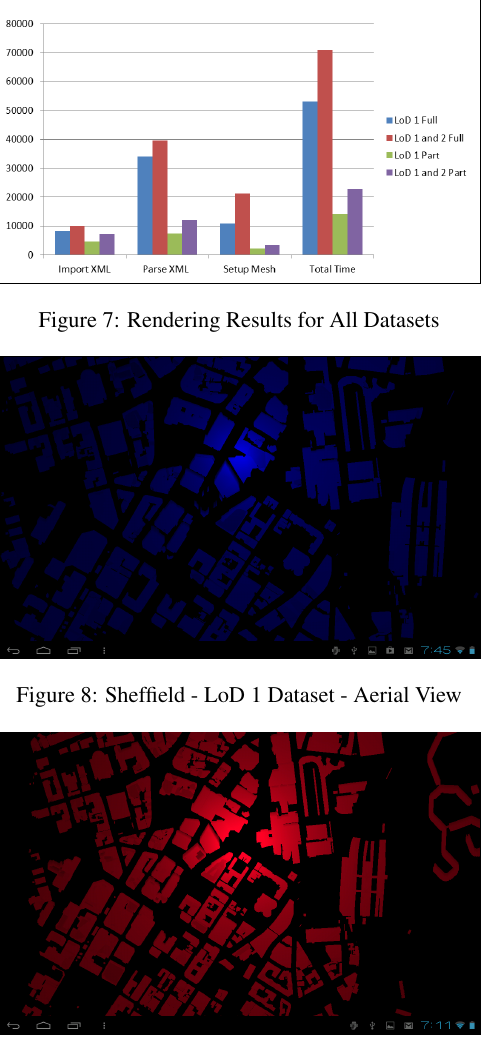
Figure 9: Sheffield - LoD 1/2 Dataset - Aerial View